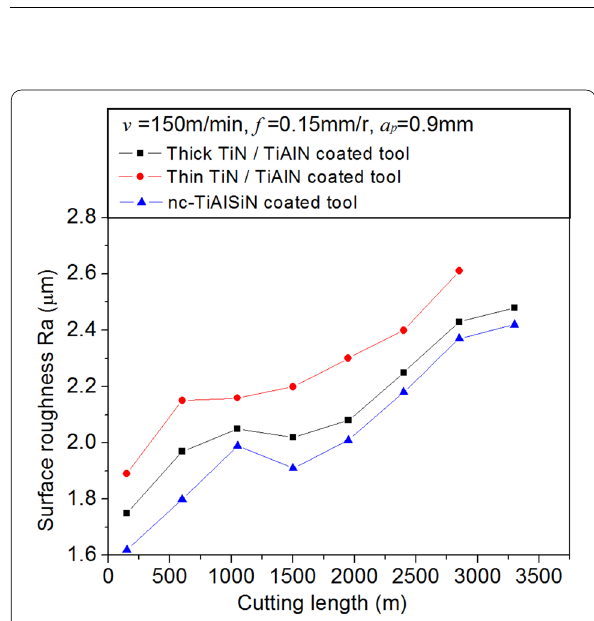
Figure 10 Surface roughness values as functions of cutting length of the three coated tools (